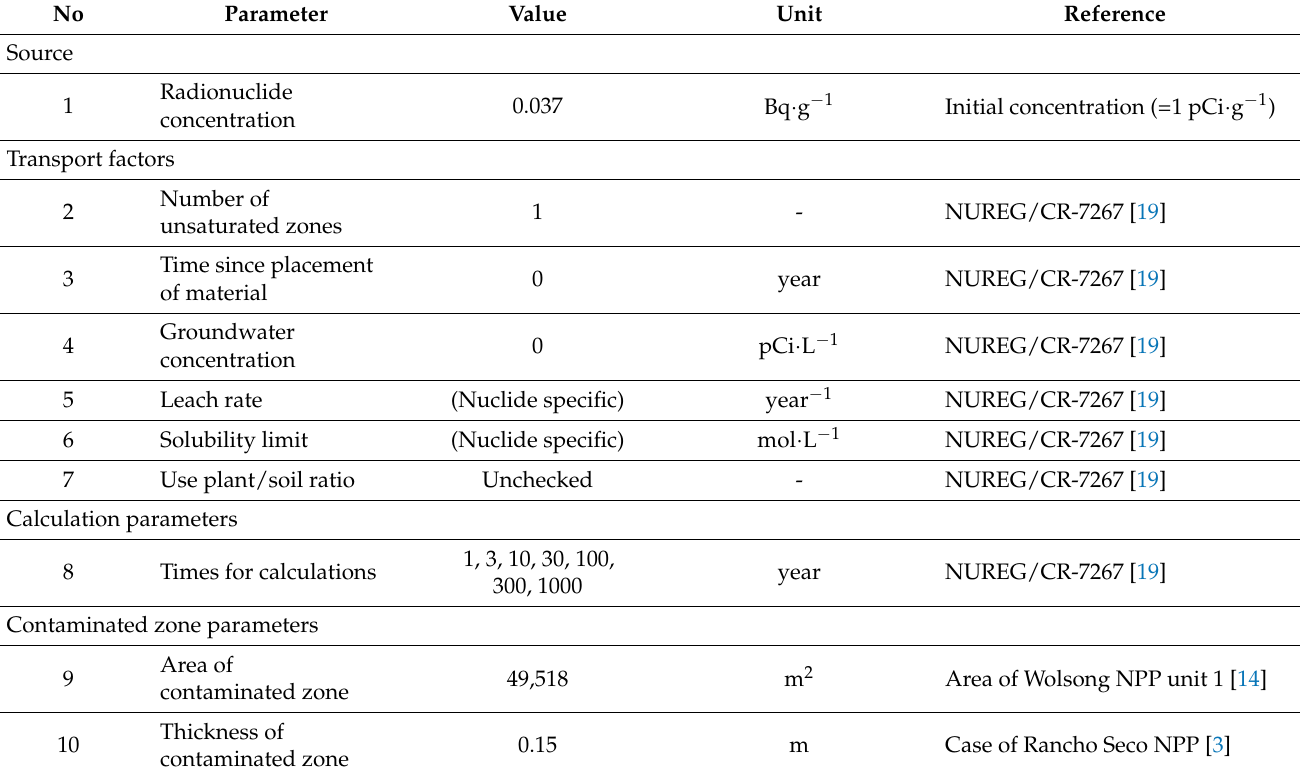
Table A1. Input parameter database for RESRAD-ONSITE code employed in the present